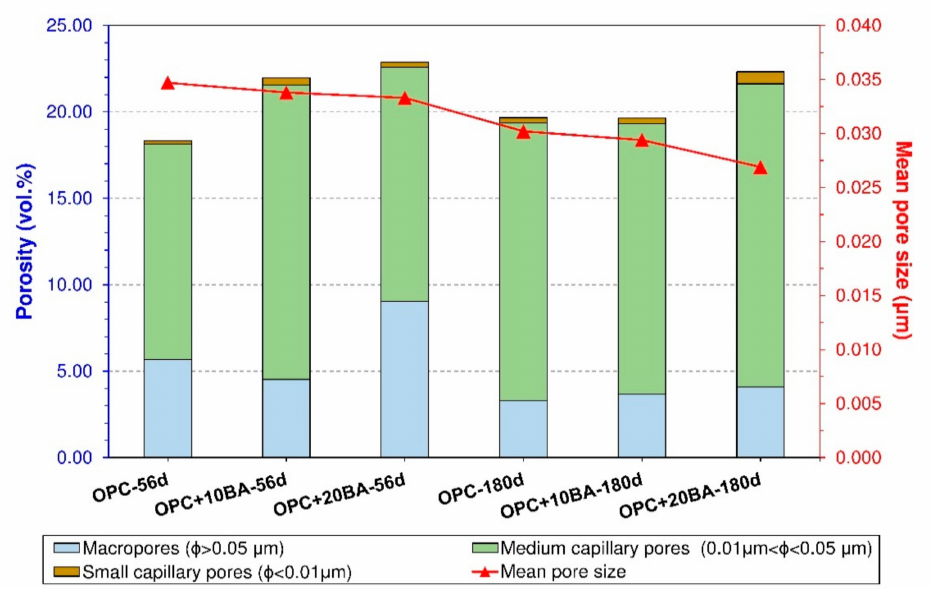
Figure 2. Pore system properties in cements soaked in a 0.3 M Na 2 SO 4 solution for 56 or 180 d.